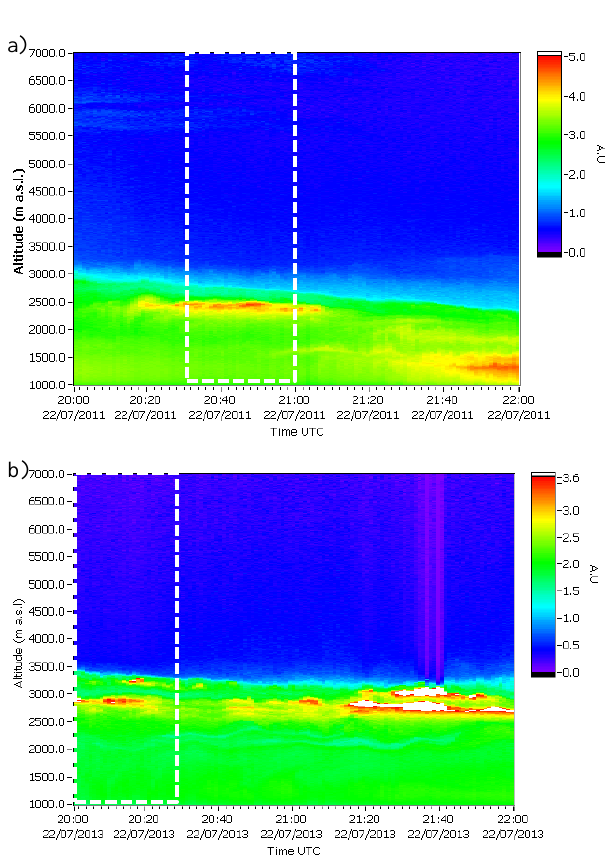
Figure 2. (a) Lidar RCS time series at 532nm (arbitrary units) on 22 July 2011 from 20:00 to 22:00UTC. Features shown here are aerosol related. (b) Lidar RCS time series at 532nm (arbitrary units) on 22 July 2013 from 20:00 to 22:00UTC. For this case, some clouds were present between 21:35 and 24:45, leading to a strong attenuation of the RCS. On both cases data were cloud-screened be- fore proceeding to the investigation of hygroscopic growth effects.